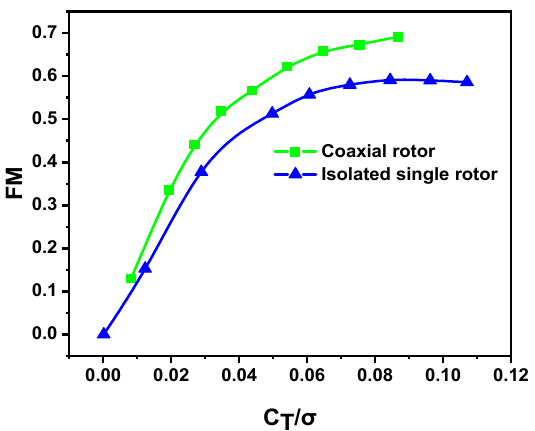
Figure 6. Relationships between power coefficient (C P ) and thrust coefficient (C T ) of upper, lower, and isolated single rotors.